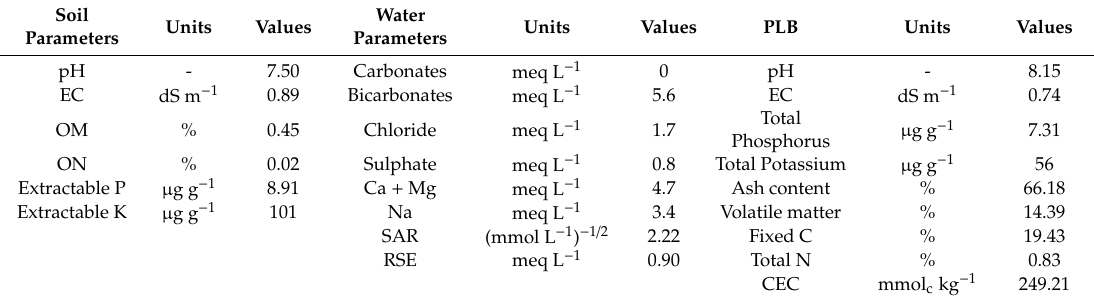
Table 1. Characteristics of soil, irrigation water, and biochar used in the study